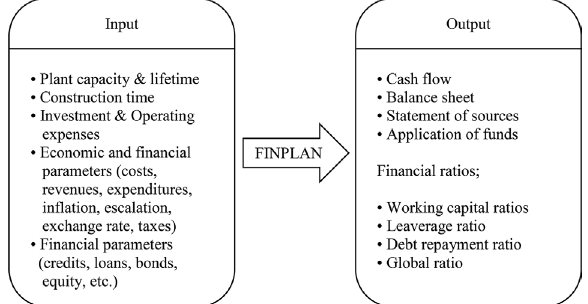
Figure 1. Data processing